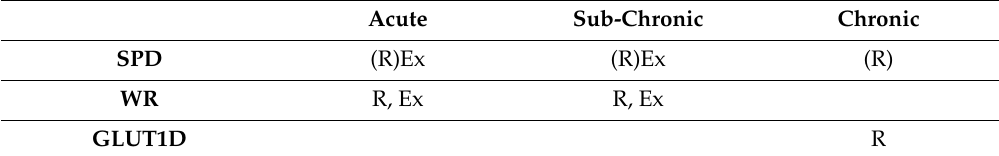
Table 1. Treatment groups in the di ff erent rodent models.